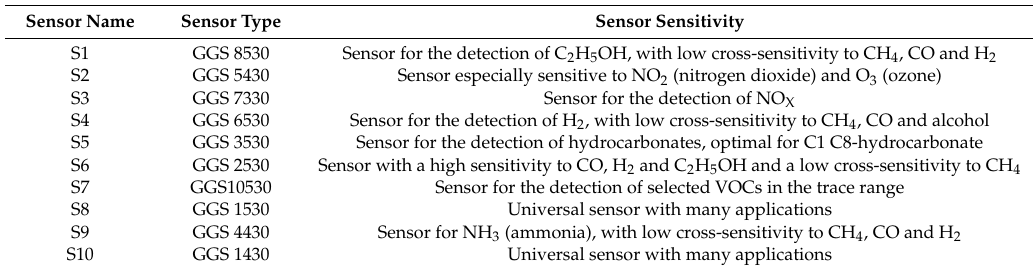
Table 1. Tested sensors and related specifications.